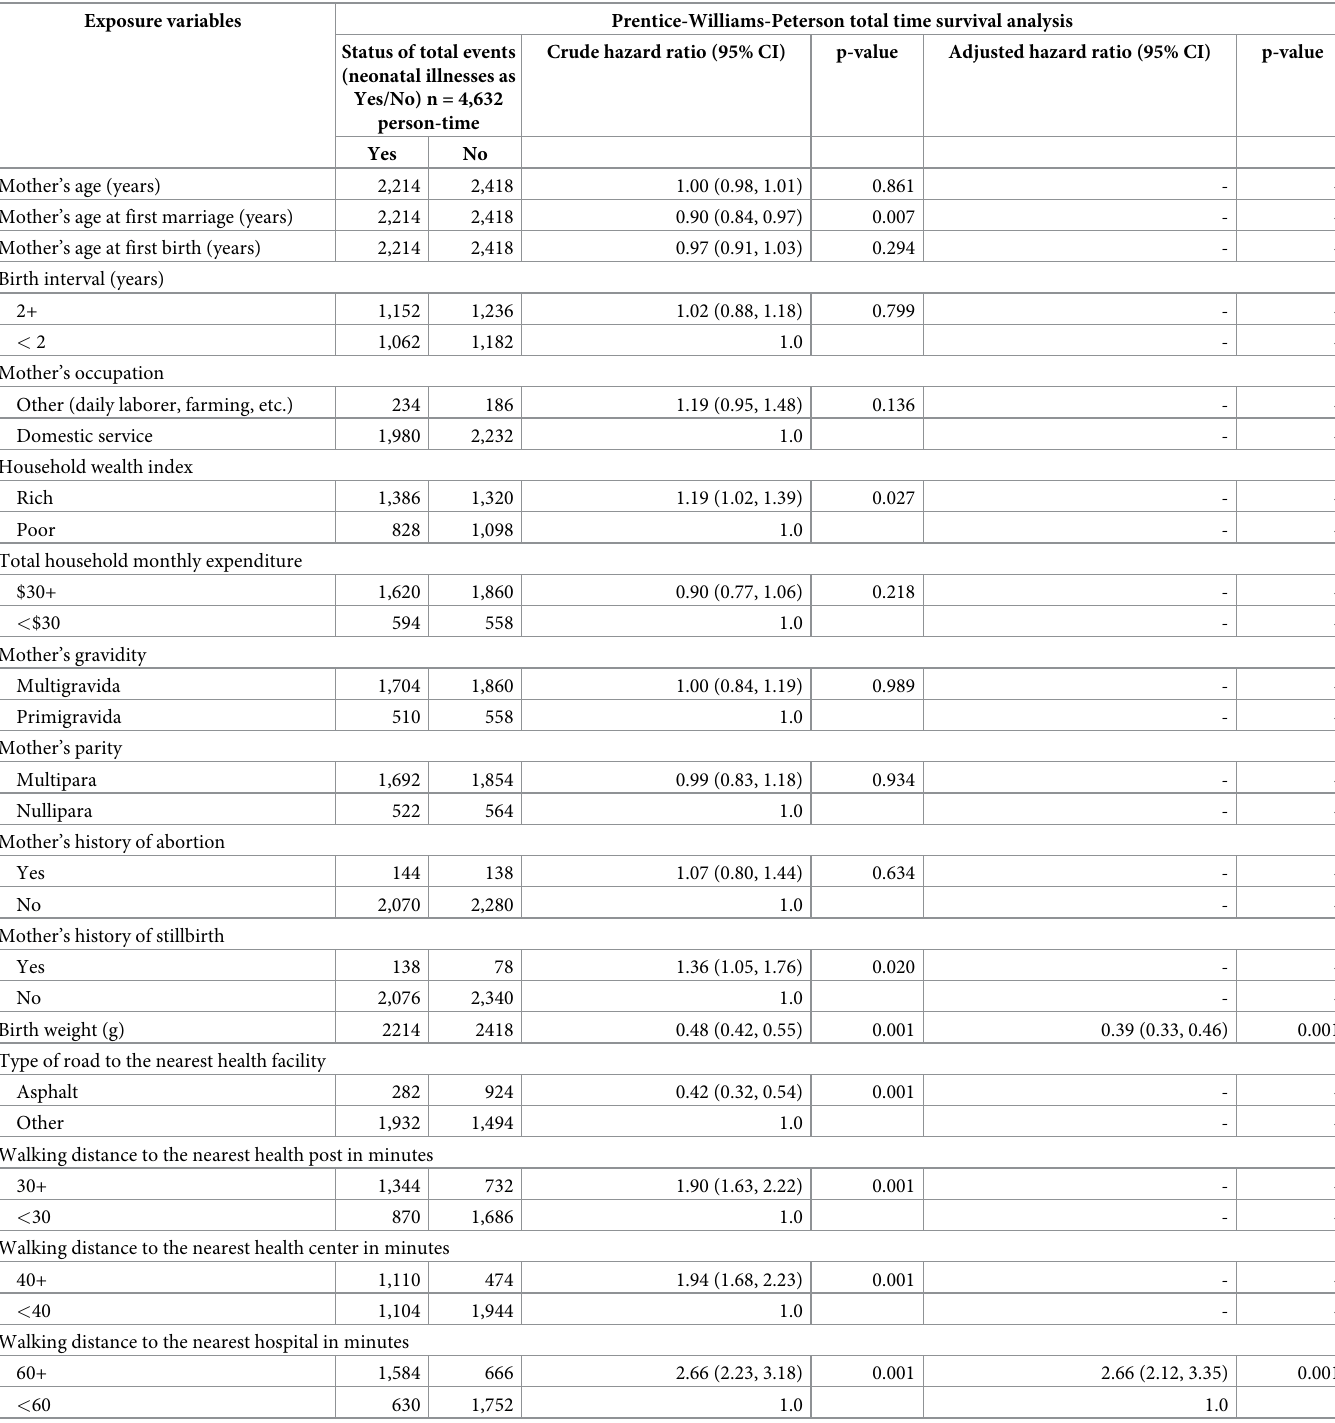
Table 5. Prentice, Williams, and Peterson’s total time Cox-type survival model analysis for neonatal illnesses in rural southern Ethiopia, May 2017 to July 2018. Exposure